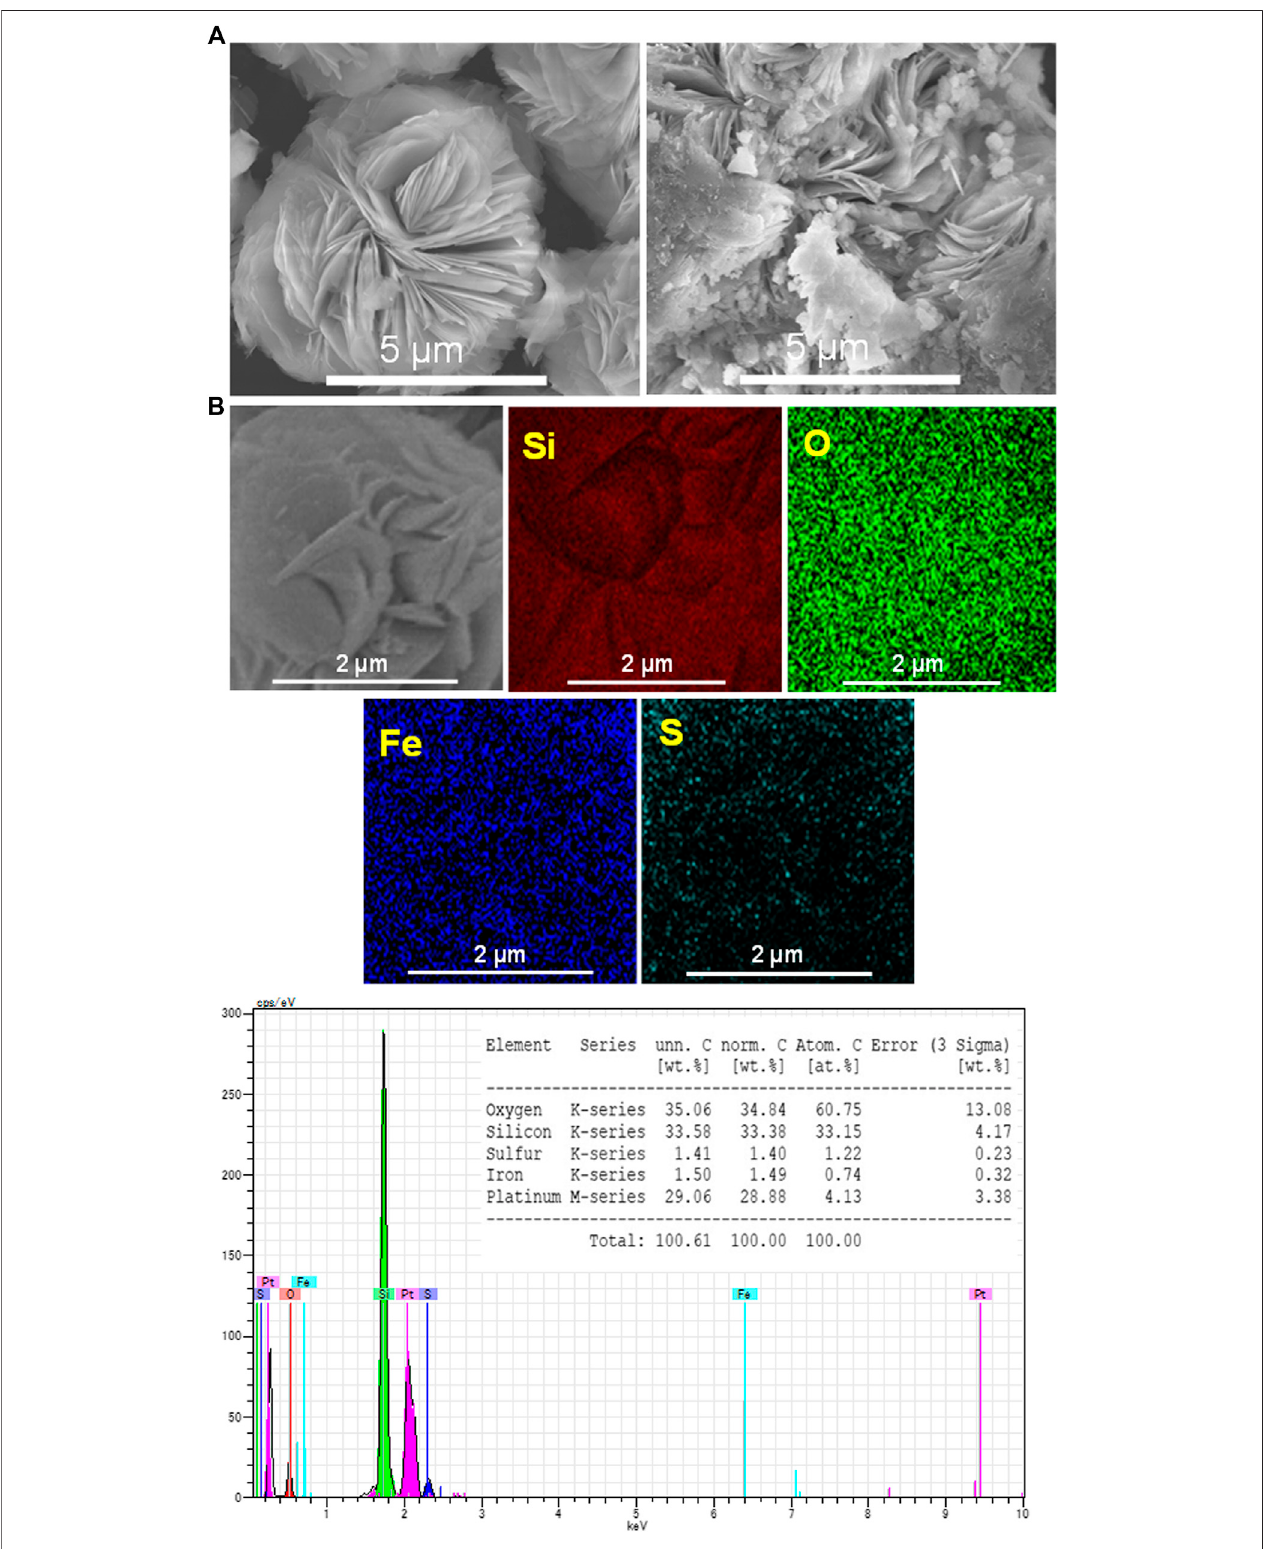
FIGURE 2 | (A) SEM images of H-mag and FHS/H-mag and (B) EDS elemental mappings and EDX spectrum of FHS/H-mag.